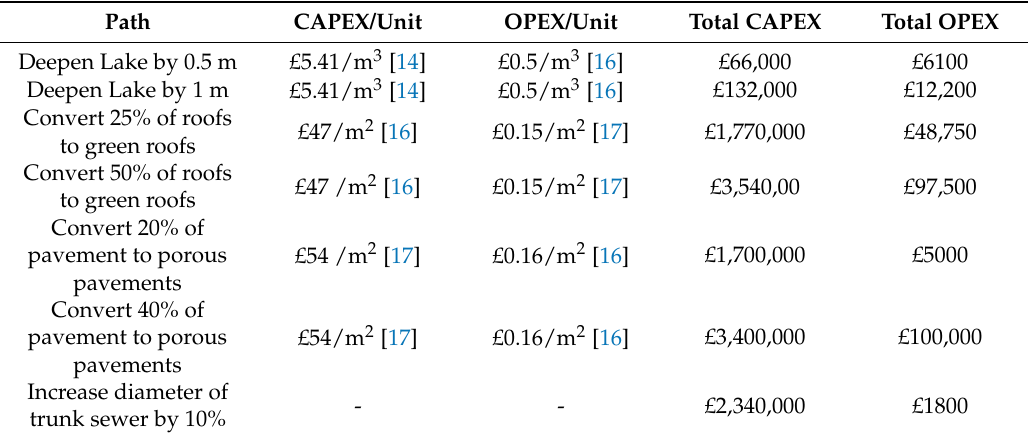
Table 2. CAPEX and OPEX of adaptation